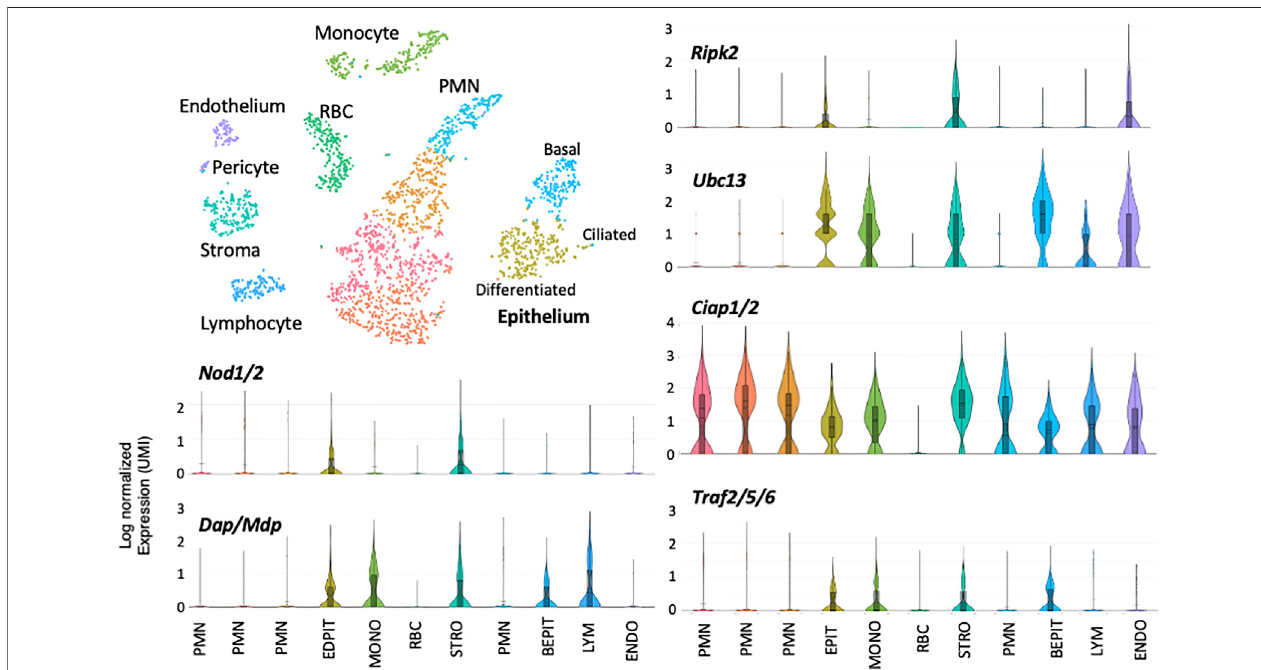
FIGURE 4 | Single-cell RNA-Seq data from the ME 6 h after NTHi infection. Within hours of infection the ME is in fi ltrated by large numbers of neutrophils (PMNs), andRBCsarealsopresent.UpregulationofmanyRIP2-relatedgenesamongisalsoevidentinsomecelltypes,withtheexceptionofPMNsandRBCs.Expressionofthe Nod genes was prominent only in epithelial and stromal cells. Ripk2 was similarly observed in epithelial and stromal cells, but in endothelial cells as well. For all other cell types,thegreatmajorityofcellsshowednoexpressionofthesegenes.ThusonlyMEepithelialandstromalcellsexpressed substantiallevelsofRIP2-relatedgenes involved in mediating in fl ammatory and antibacterial responses.